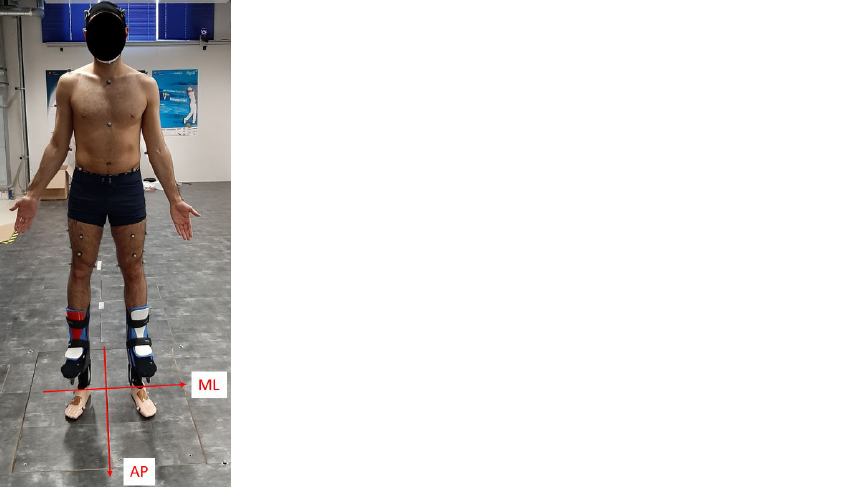
Figure 2. Subject wearing the prosthetic simulators with prosthetic feet + feet